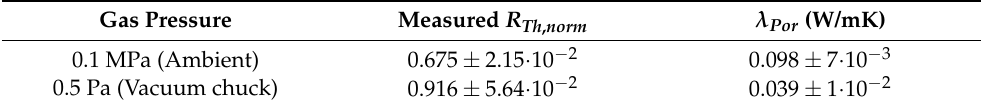
Table 2. Estimation of λ Por for AP300/30 microstructures from normalized measurements ( n = 5) of R Th using the model presented in Equation